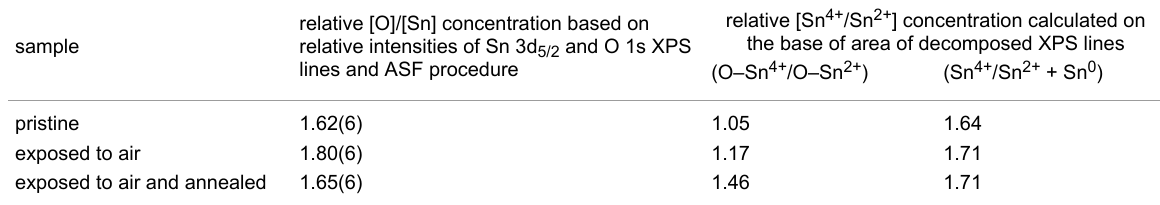
Table 1: Relative concentration of main elements of RGVO SnO 2 nanolayers estimated on the basis of a recently used ASF procedure [27] as well as on the basis of the decomposed of the O1s and Sn3d 5/2 spectral lines shown in Figure 2.